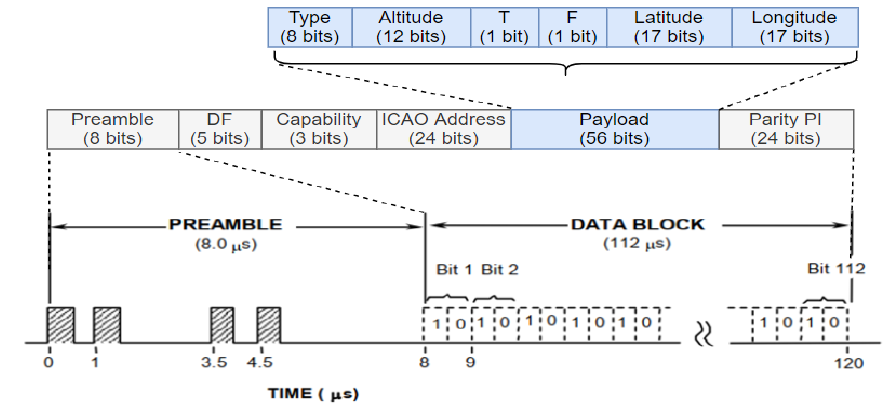
Figure 2. ADS-B waveform and message format .